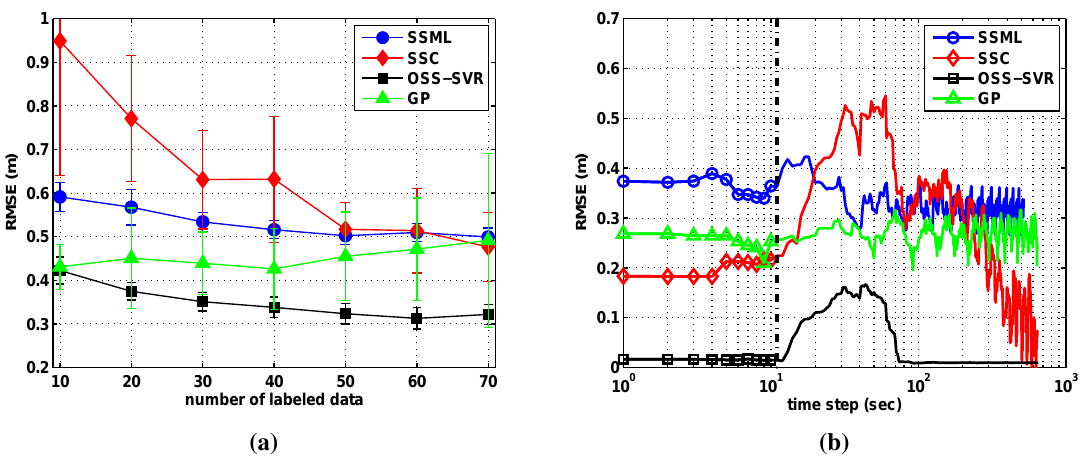
Figure 4. Localization performance of circular trajectory according to ( a ) the number of labeled data and ( b ) the change of the model interrupted by bias noise.